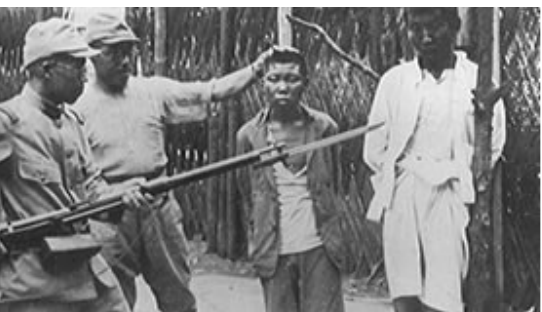
Figure 10. Japanese abuse young Chinese cap- tives. Source: LOOK